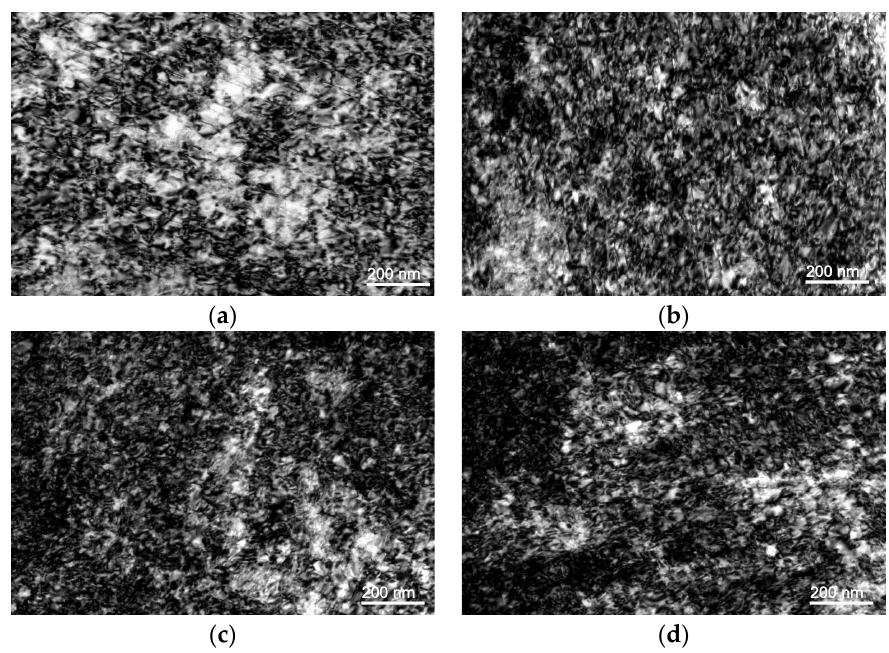
Figure 13. Bright fi eld TEM images showing the dislocation density seen in the sample after fracture; ( a ) 298 K; ( b ) 213 K; ( c ) 113 K; and ( d ) 20 K.